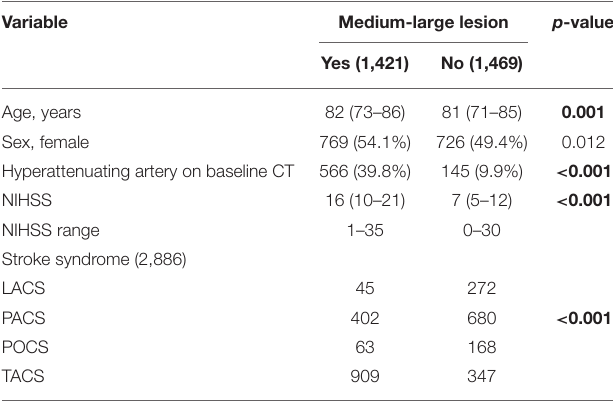
TABLE 1 | Baseline clinical and demographic differences between those with and without a confirmed medium-large ischaemic lesion at any time, n = 2,890.